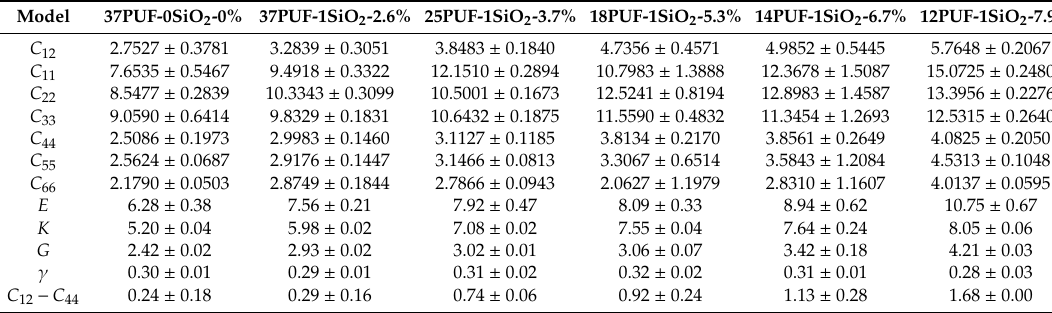
Table 3. Micro mechanical properties of the PUF-SiO 2 models (GPa ± standard